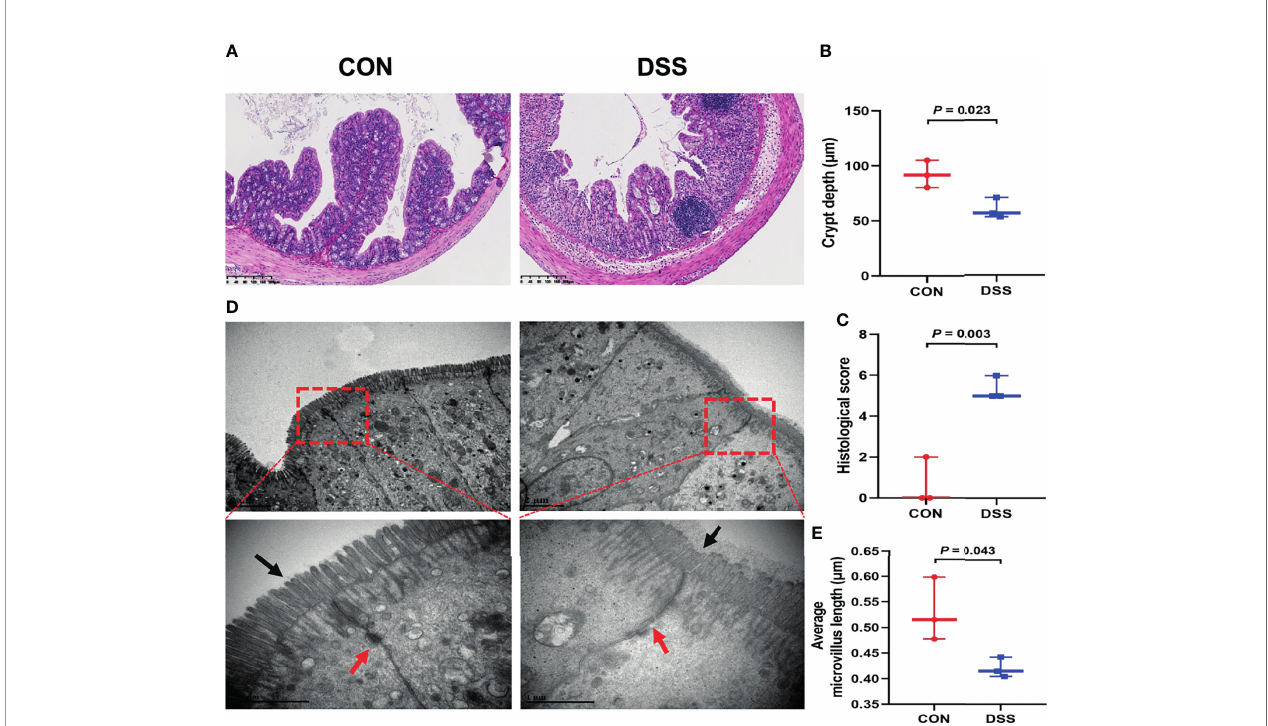
FIGURE 4 | DSS-induced colonic histological changes and barrier dysfunction in mice. (A) The representative H&E staining of the colonic sections, the bars represent 200 m m; (B) The colonic crypt depth; (C) histological scores; (D) Ultrastructural changes of TJs and microvilli under transmission electron microscopy (12,000× and 40,000×); (E) Average microvillus length. Data were expressed as means ± SEM (n =